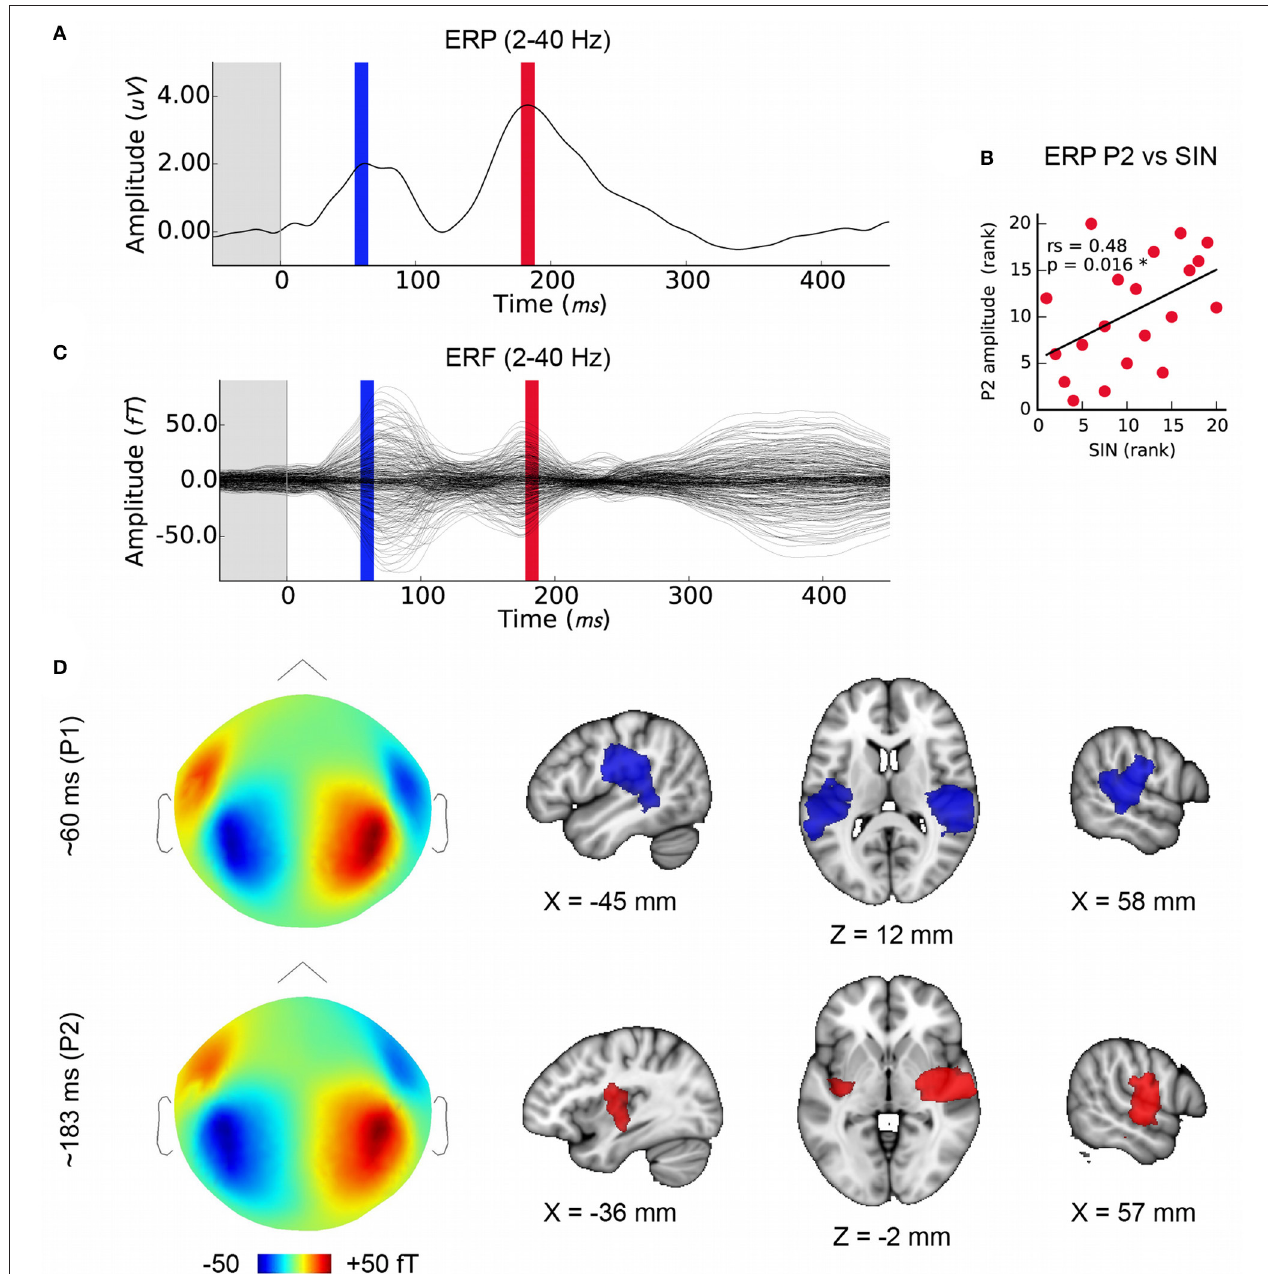
FIGURE 3 | Later cortical evoked responses and their origins. (A) Time courses of the lower frequency evoked response potentials (ERPs) from EEG data with the time windows used for MEG source analysis marked (P1: blue, P2: red), and (C) evoked response fields (ERFs) from simultaneously recorded MEG data. Each is averaged over subjects ( N = 20). (B) The amplitude of the P2 ERP wave peak (red) correlates with SIN accuracy. (D) Group-level MEG topographies (left, strength and polarity is indicated in the color bar below) and source analyses of P1 and P2 component origins using (1mm MNI space; cluster threshold; p < 0.005). Note that single-channel EEG data are used to derive P2 amplitudes in order to maximize interpretability with respect to previous work whereas source localization is performed on concurrent MEG